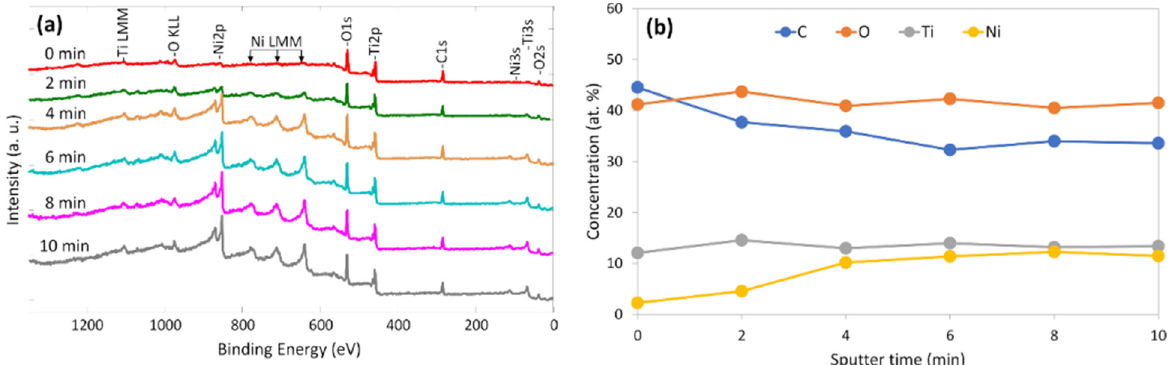
Figure 7. XPS analysis of C-doped TiO 2 film with the Ni underlayer deposited on HDPE beads: ( a ) survey spectra and ( b ) distribution of elemental composition after different sputtering time.